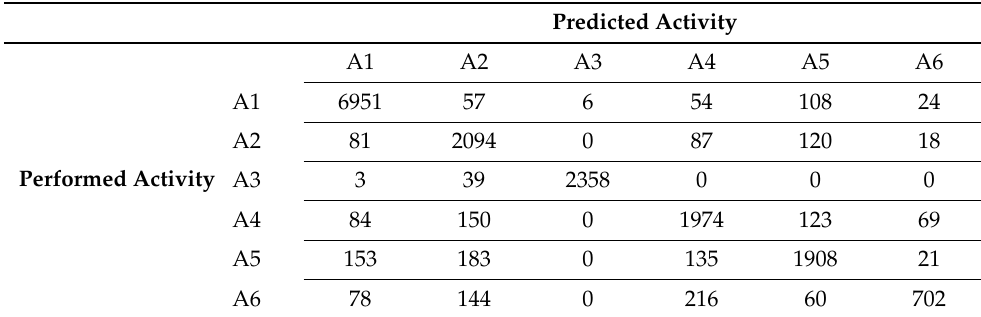
Table 10. The confusion matrix obtained for the third evaluation scenario.